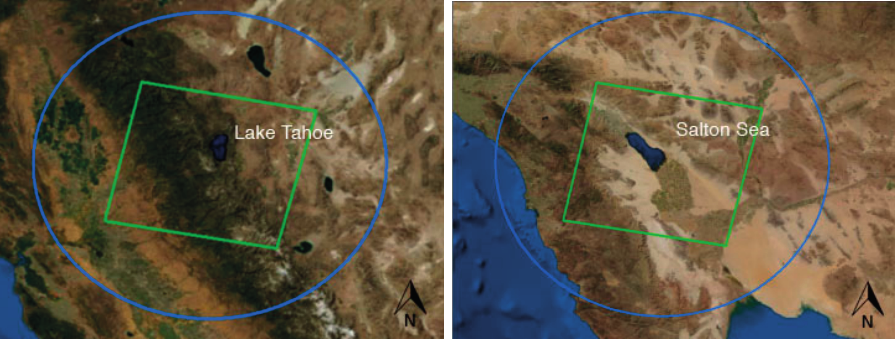
Figure 8. The 185 km wide scene boundaries of the standard Lake Tahoe, located at 39N, 120W ( left ), and Salton Sea, located at 33.3N, 115.8W ( right ), image frames are indicated by the green box. The blue circle indicates the 15° ring source of stray light (though the stray light does not necessarily come from the whole circle). In both cases, the source of the stray light is primarily from land (given that no snow or clouds are covering the surface) outside the area observed by